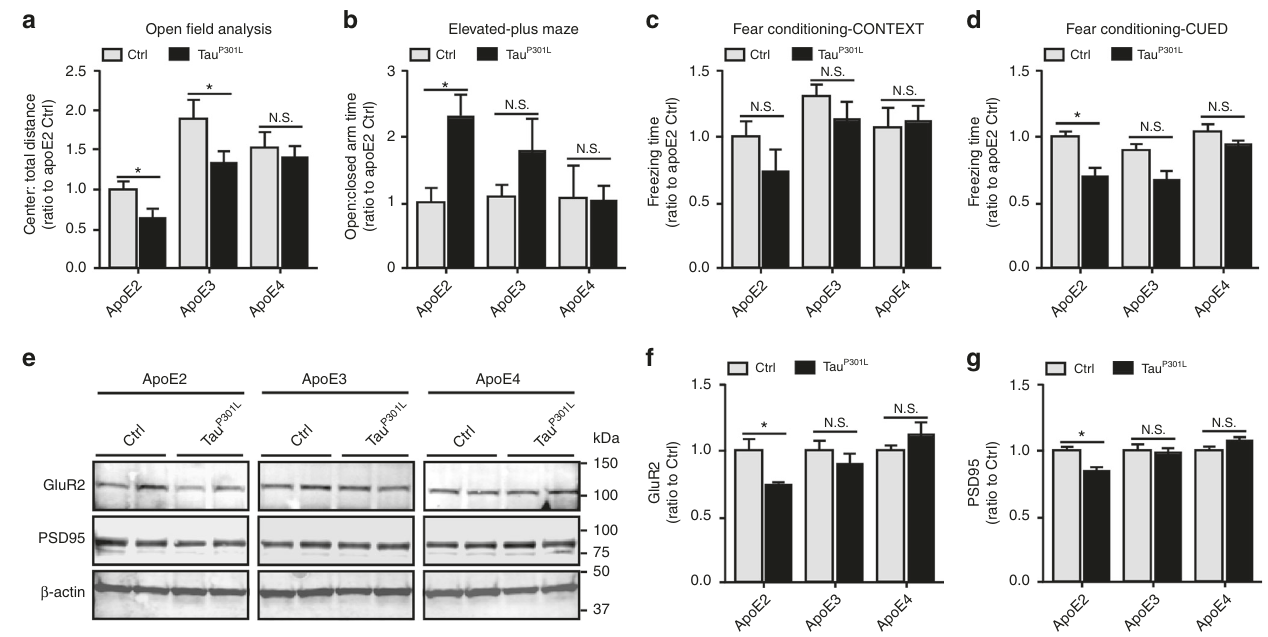
Fig. 2 Behavioral abnormalities and compromised synaptic integrity in Tau P301L -apoE2 mice. Behavioral performance was assessed in control mice (Ctrl, AAV-GFP-injected, n = 12 mice per group, mixed gender) and Tau P301L -apoE2, -apoE3, and -apoE4 mice ( n = 13 mice for Tau P301L -apoE2 group, n = 20 mice for Tau P301L -apoE3 group, n = 22 mice for Tau P301L -apoE4 group, mixed gender) at 6 months of age. a Open- fi eld analysis was assessed and the ratios of time spent in the center quadrant to total distance traveled in the open- fi eld apparatus are shown. b Exploratory behavior was evaluated in the elevated plus maze and the ratios of the time spent in open arms to close arms are shown. c , d Fear conditioning test was utilized to examine the associative memory. The percentage of the time with freezing behavior in response to stimulus during context ( c ) and cued ( d ) tests is shown. Data represent mean ± SEM. e – g The amount of GluR2 and PSD95 in the cortical RIPA lysate was examined by western blotting for control mice and Tau P301L - apoE mice ( n = 6 mice per group, mixed gender) at 6 months of age. Results were normalized to β -actin levels. Data are expressed as mean ± SEM. Mann- Whitney tests followed by Bonferroni correction for multiple comparisons were used. * P < 0.0167; N.S. not signi fi